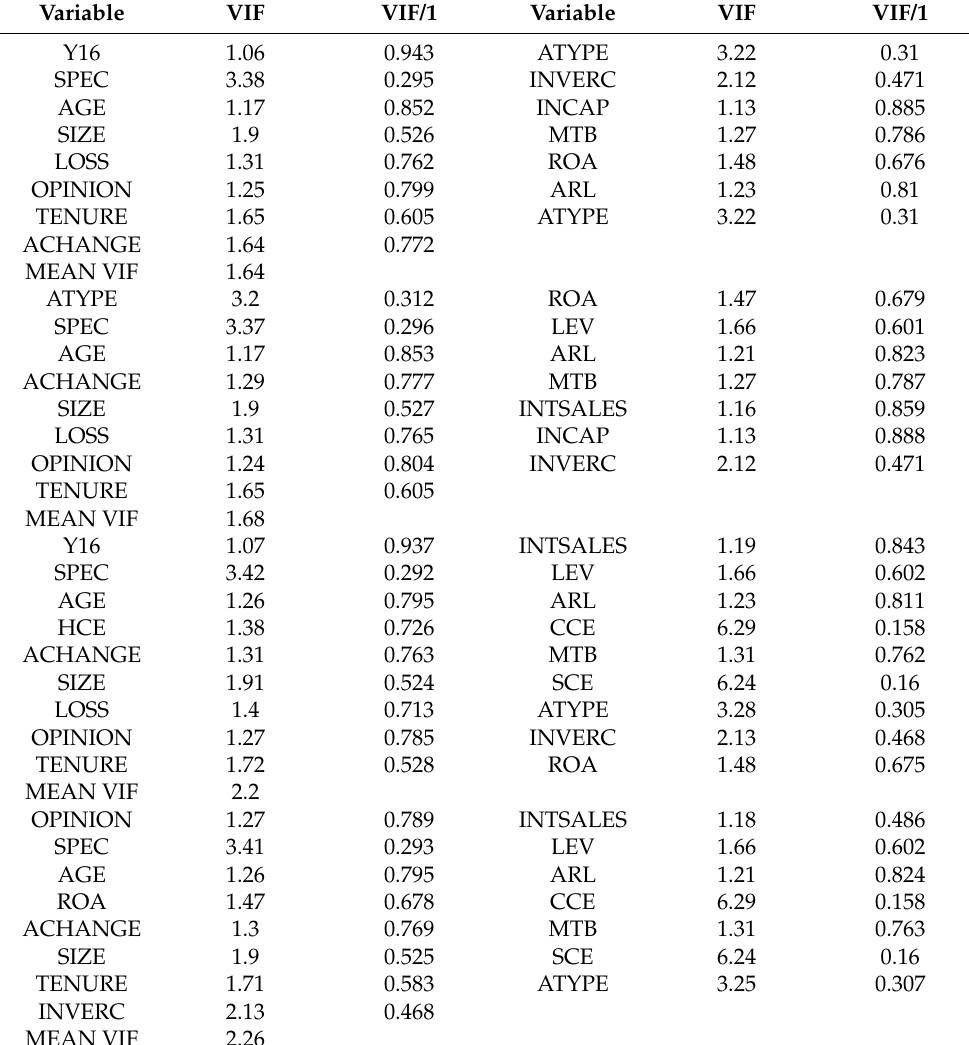
Table A2. The VIF test of the first